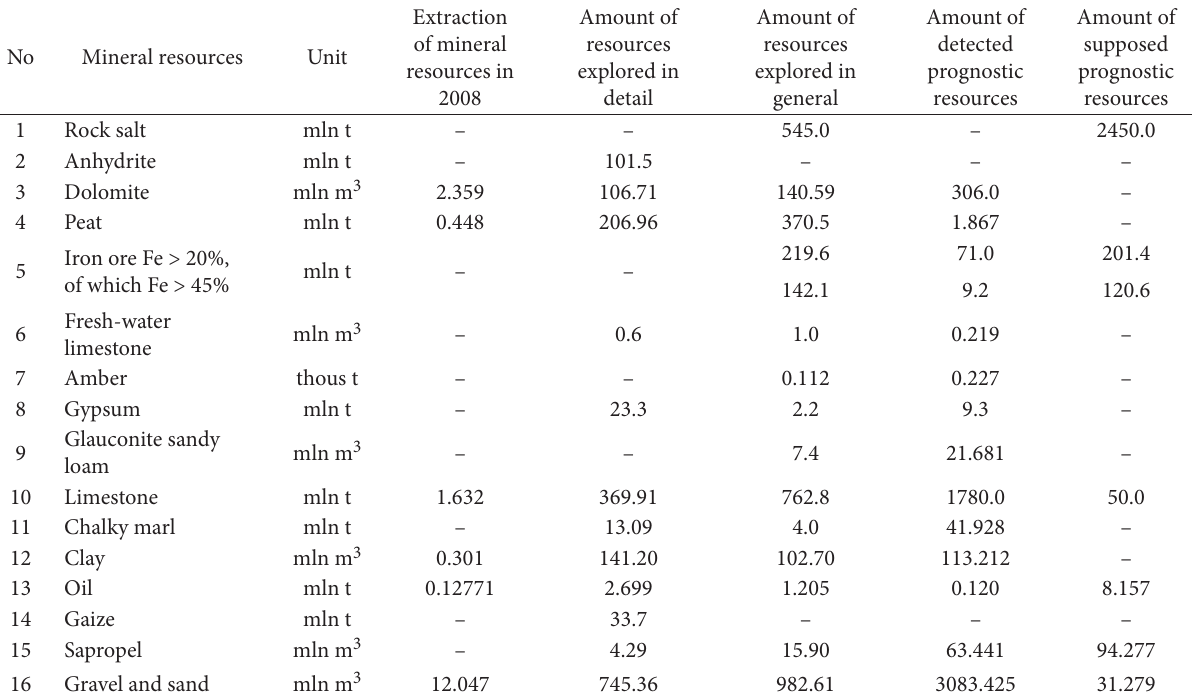
Table 1. Mineral resources of the Republic of Lithuania according Lithuanian Geological Survey in 2008 No Mineral resources Unit